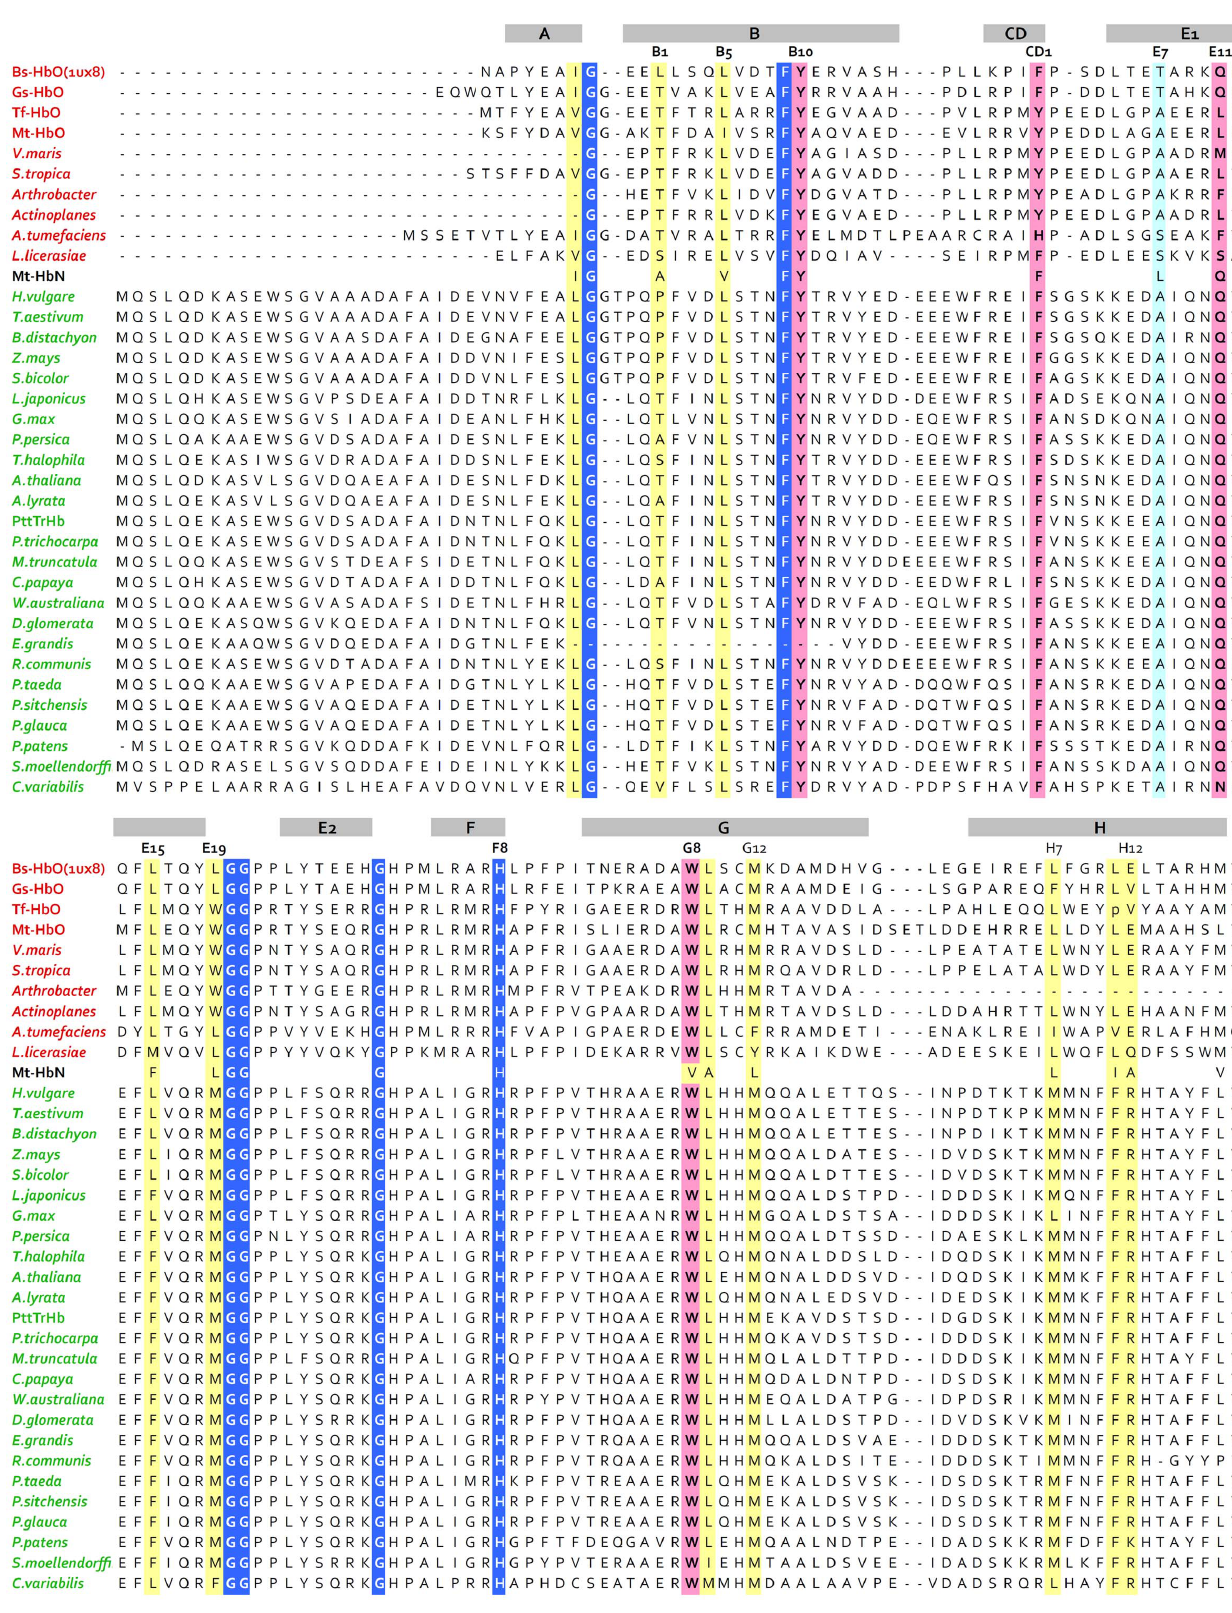
Figure 1. Structure-based sequence alignment of selected group II TrHb sequences from bacteria and plant species. The sequence alignment was generated by superposing the structures and then aligning other bacterial and plant sequences. The a -helices of the X-ray structure of Bs-HbO (1UX8) are shown as grey background on the top of the alignment. The a -helices in vertebrate Hbs with 3-on-3 arrangement of a -helices are